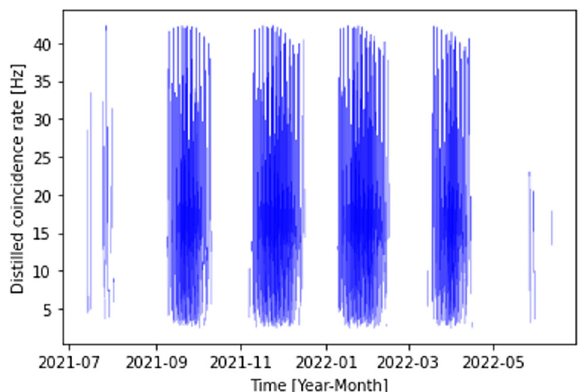
Fig. 8 Distilled coincidence rate for the low Earth orbit at 600 km with inclination of 50 degrees. The wavelength of 810 nm allows only night- time operation. The quantum ground stations are assumed to be equipped with super-conducting nanowire single photon detectors. Simulation from July 1, 2021 to July 1, 2022 (meteorological effects not considered).